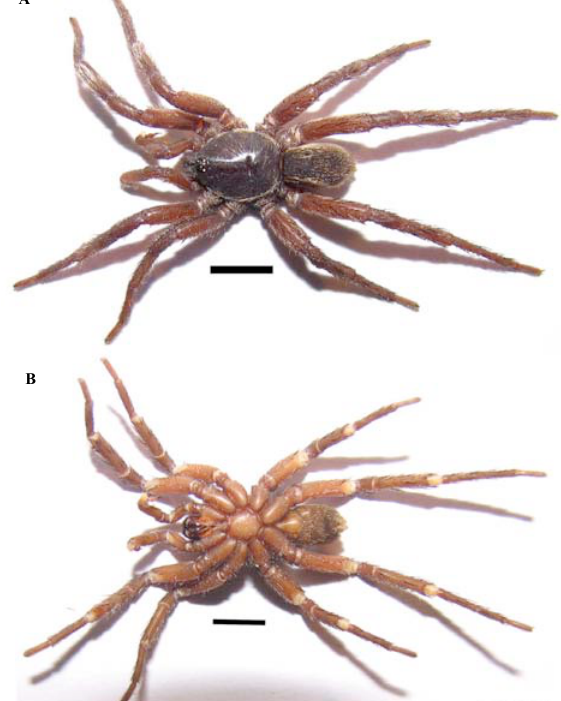
Figure 2. Sipalolasma arthrapophysis male. A. Dorsal view. B. Ventral view. (Scale